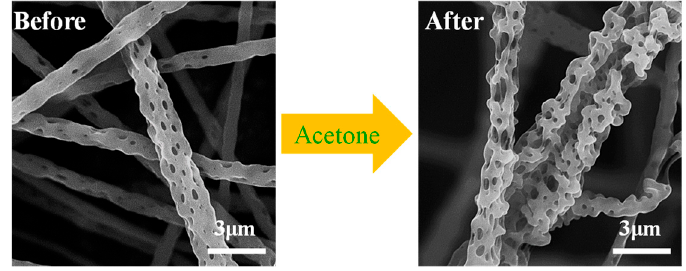
Figure 7. The changes of pores on the fiber surface before and after acetone treatment.